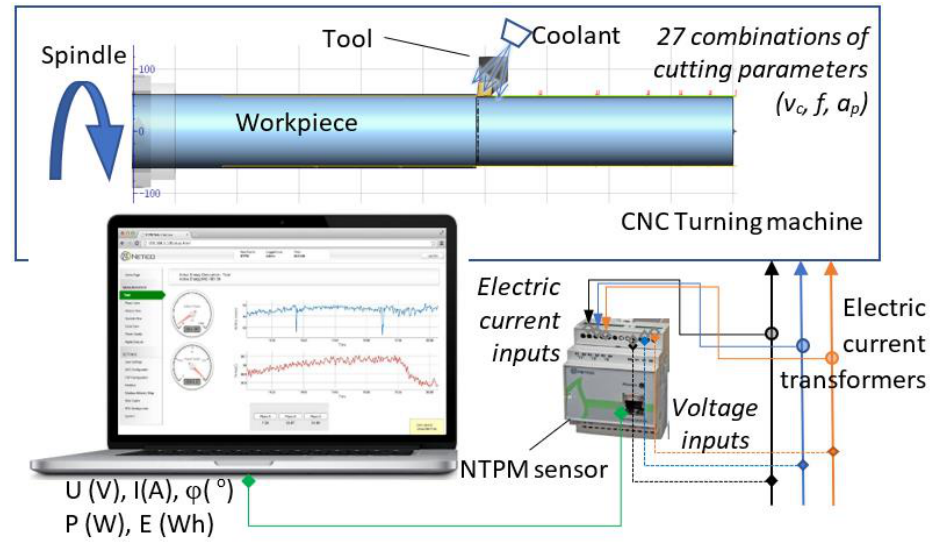
Figure 3. Schematic of measuring the (total) electric energy consumption and engaged power of the turning machine.